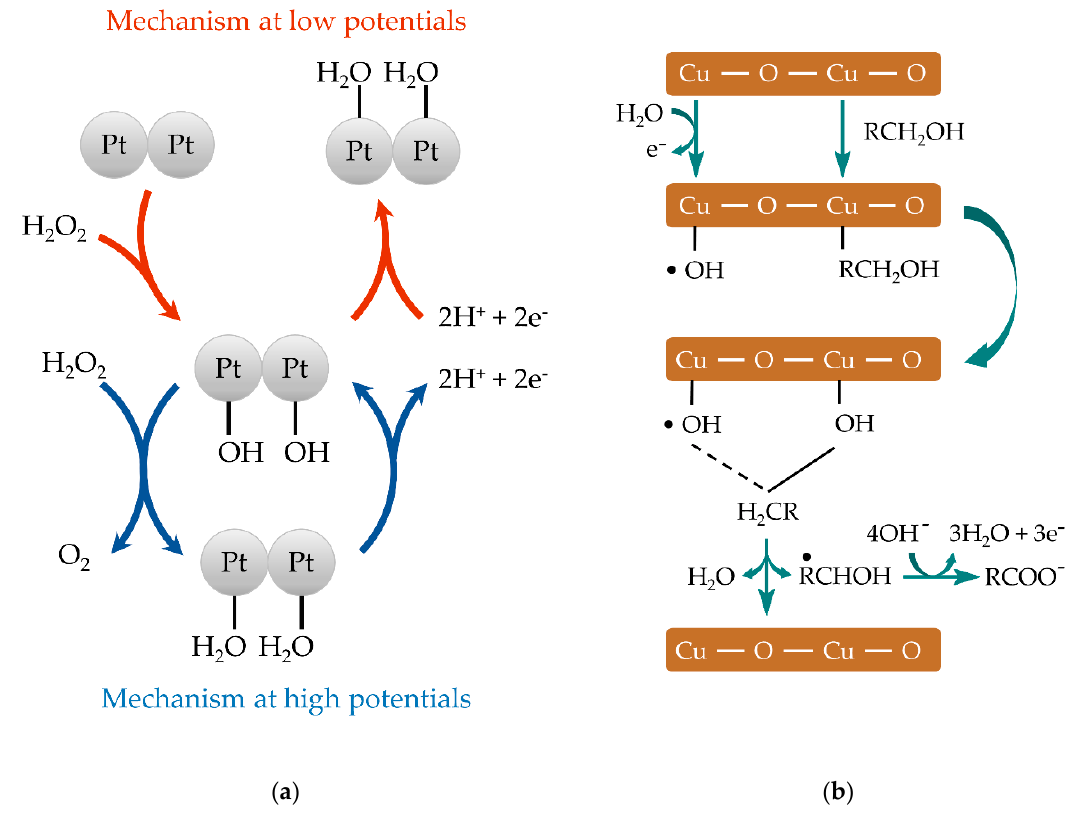
Figure 2. Schemes showing the proposed mechanism of ( a ) hydrogen peroxide oxidation onto platinum NPs [71] and ( b ) sugar oxidation onto copper NPs [62].